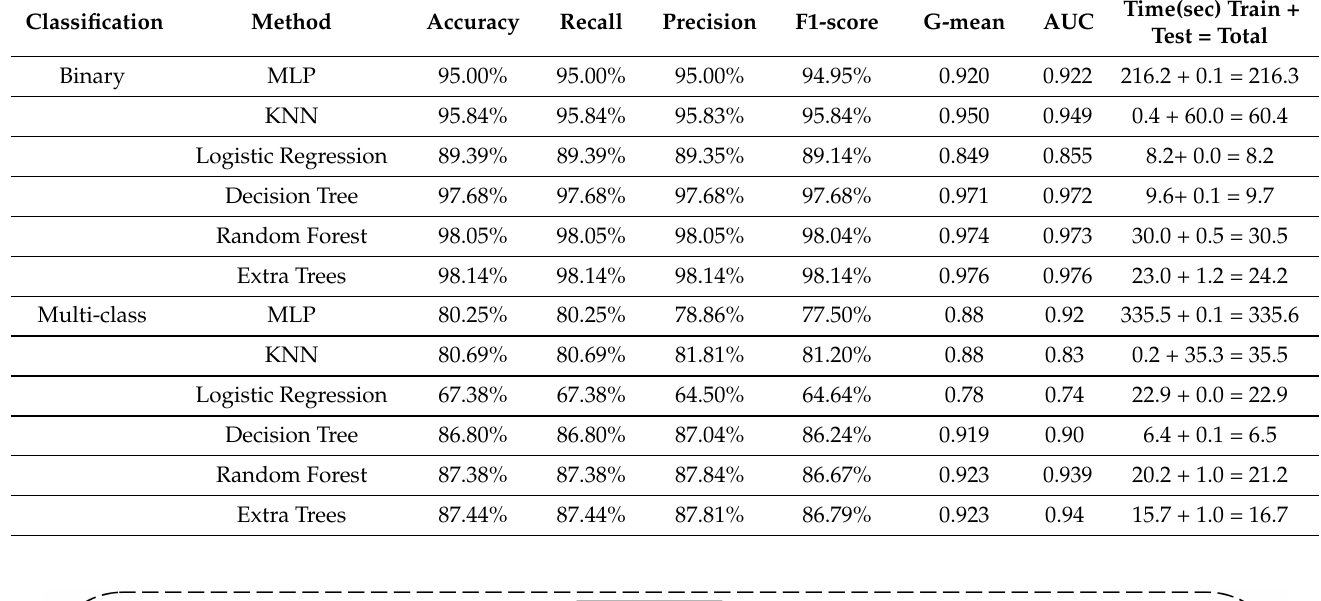
Table 6. Classification results on GAN + original dataset using chi-square feature selection.